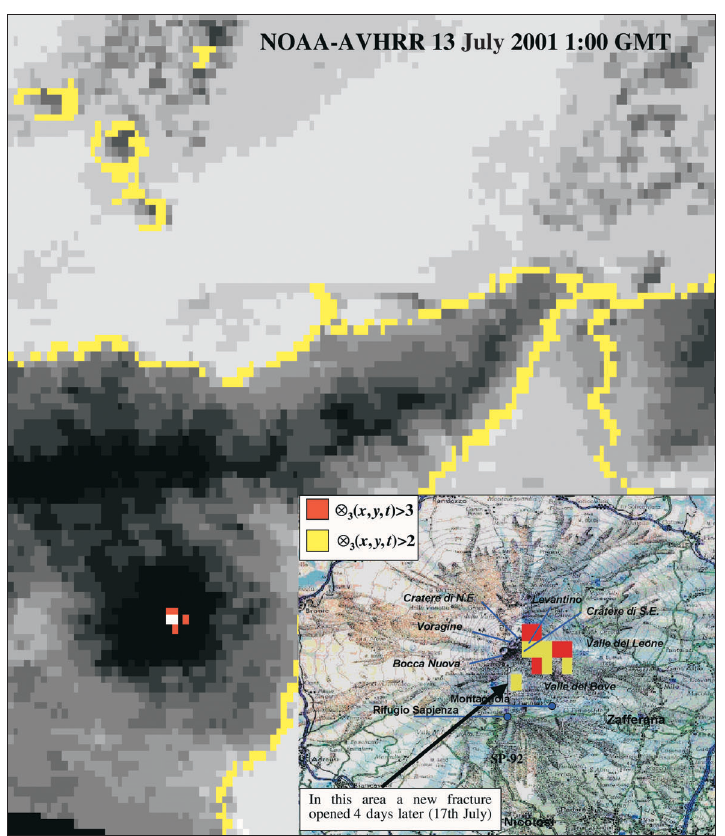
Fig. 4. NOAA/AVHRR July 13th 2001, 1:00 GMT: hot-spots depicted in red are the ones detected by RAT (at > 3) on Mount Etna in correspondence with lava flows consequent to the strombolian eruptions from ⊗ 3 ( x , y , t ) SE Crater and Levantino which occurred on 7th and 13th July. In background AVHRR channel 4 brightness tem- peratures are depicted in grey tones (light tones correspond to lower BT values), coast-lines are depicted in yel- low. Results of RAT analysis are projected on a map of Mount Etna shown in the box corner. In this case also thermal anomalies of lower intensity (with ⊗ 3 ( x , y , t ) > 2) are depicted (in yellow). Note the isolated anomaly (that, differently from the others, cannot be related to lava flows) detected within the area where four days later a new eruptive fracture opened, throwing out lava flows (see